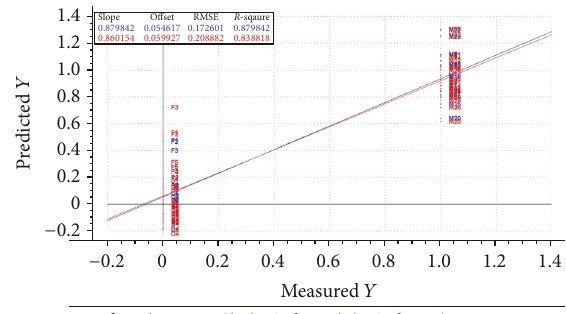
Figure2:Predictedversusmeasuredvaluesamongmuttonsamples, fraud samples, and other meats from PLS-DA model. The labels of the samples correspond to the code in Figure 1.